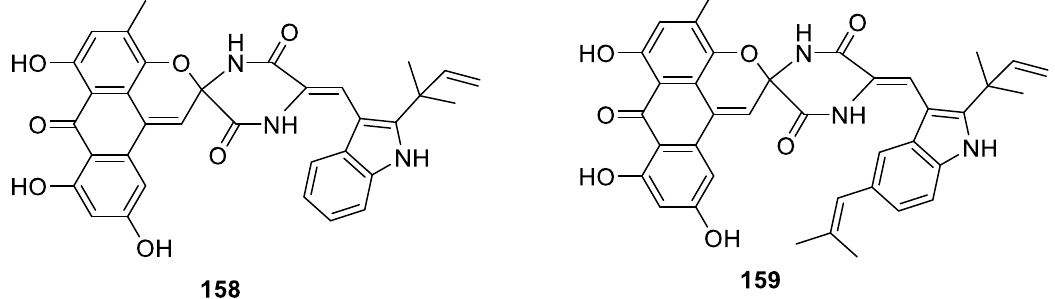
Figure 72. Pollenopyrroside A isolated from bee-collected Brassica campestris pollen.